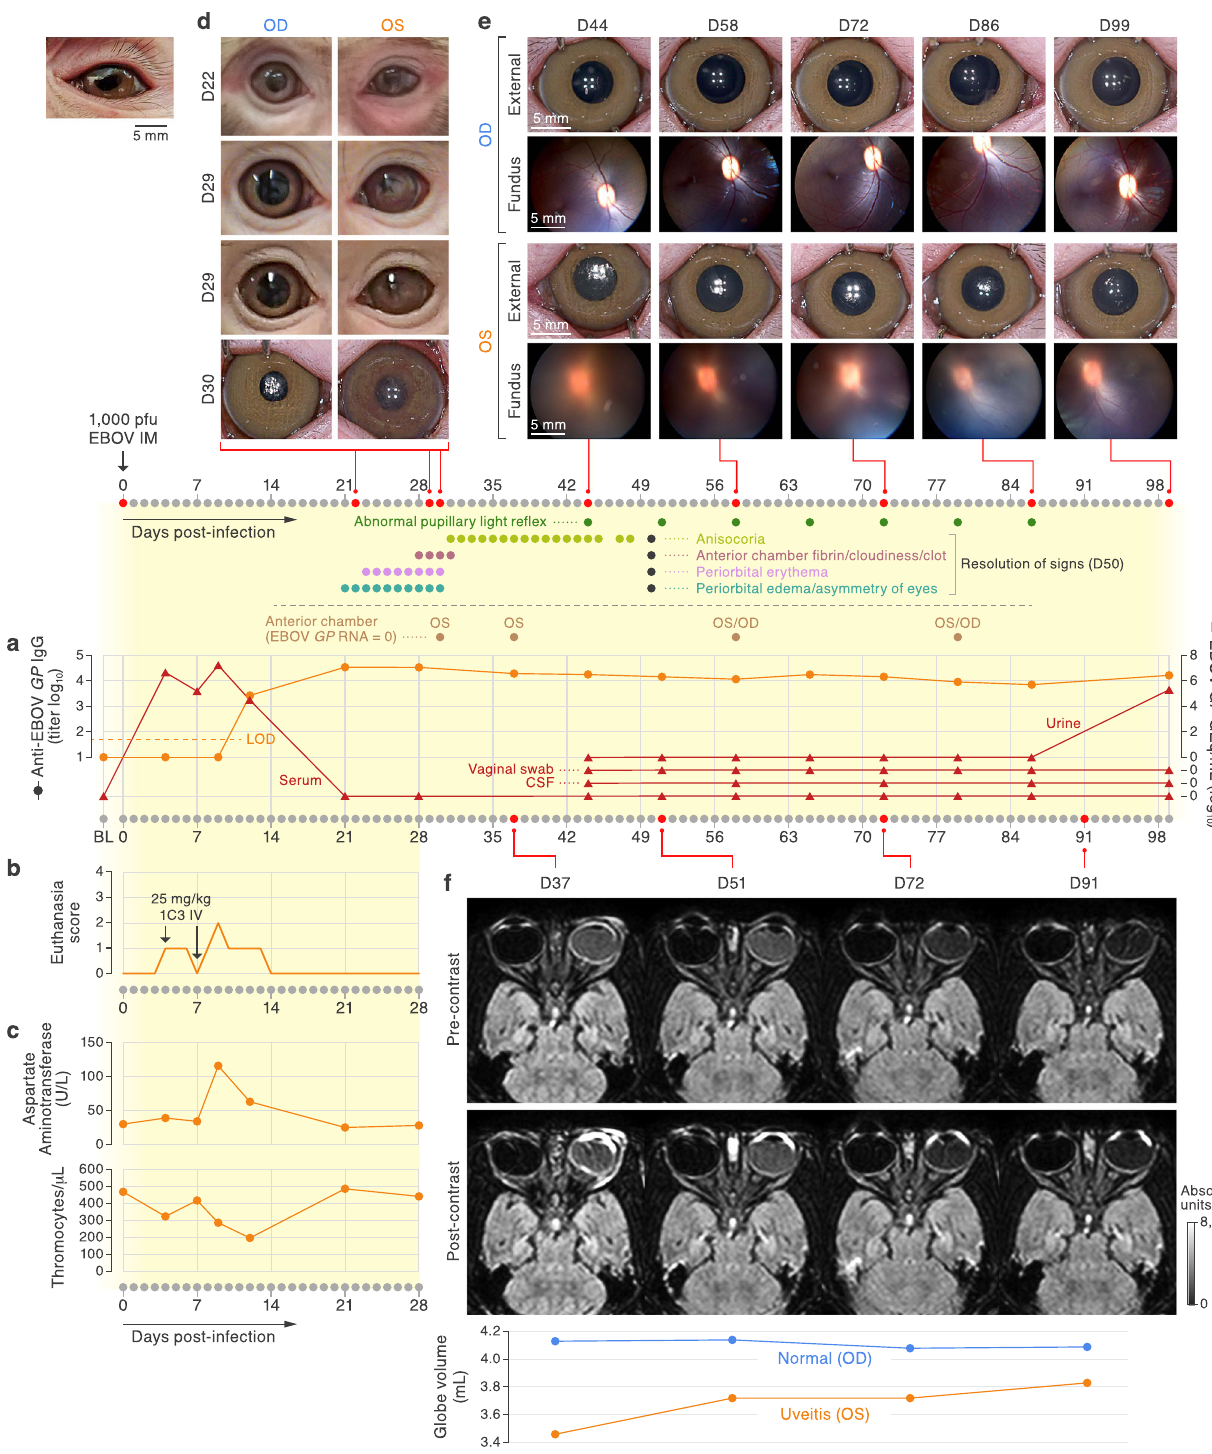
Fig. 1 Clinical history of acute EBOV infection and uveitis. a Complete timeline starting with baseline (BL) assessment and ending at necropsy on day 99. Presence of ocular clinical signs and collection of aqueous humor through anterior chamber paracentesis are indicated with dots that are called out with indicator lines. EBOV GP genome equivalents (GEq) in sera, determined by RT-qPCR (red triangles), along with rhesus monkey-speci fi c anti-EBOV GP IgG antibodies in serum detected by ELISA (orange dots). LOD, limit of detection of assay. b Clinical euthanasia scores recorded via cageside observation. Therapeutic human monoclonal antibody 1C3 dosing schedule is indicated with arrows. c Concentrations of aspartate aminotransferase (AST) and platelet counts determined in blood are shown over time. d Edema, eyelid splinting, anterior chamber fi brin clot, and iris vessel dilation visible from day 21 through day 30. e Photographs of the right (OD) and left (OS) eyes, documenting vitreous haze OS with improvement over time. f Precontrast and post-contrast magnetic resonance (MR) images of the globes. Volumetric measurements of both eyes extrapolated from MR scans show decreased eye volume OS, suggestive of hypotony. D;